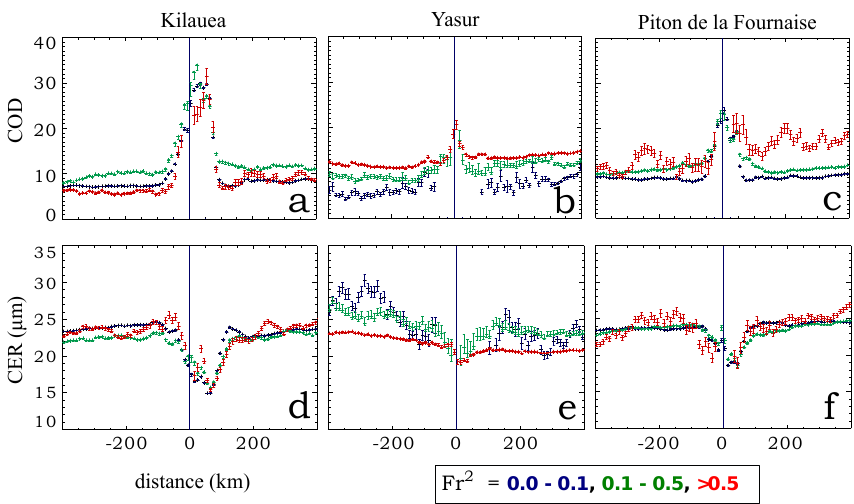
Figure 10. Profiles showing average COD (a–c) and CER (d–f) at K¯ılauea, Yasur and Piton de la Fournaise, separated according to Froude number squared ( Fr 2 ) as estimated from ECMWF data. Fr 2 =0–0.1 is blue, Fr 2 =0.1–0.5 is green and Fr 2 >0.5 is red.